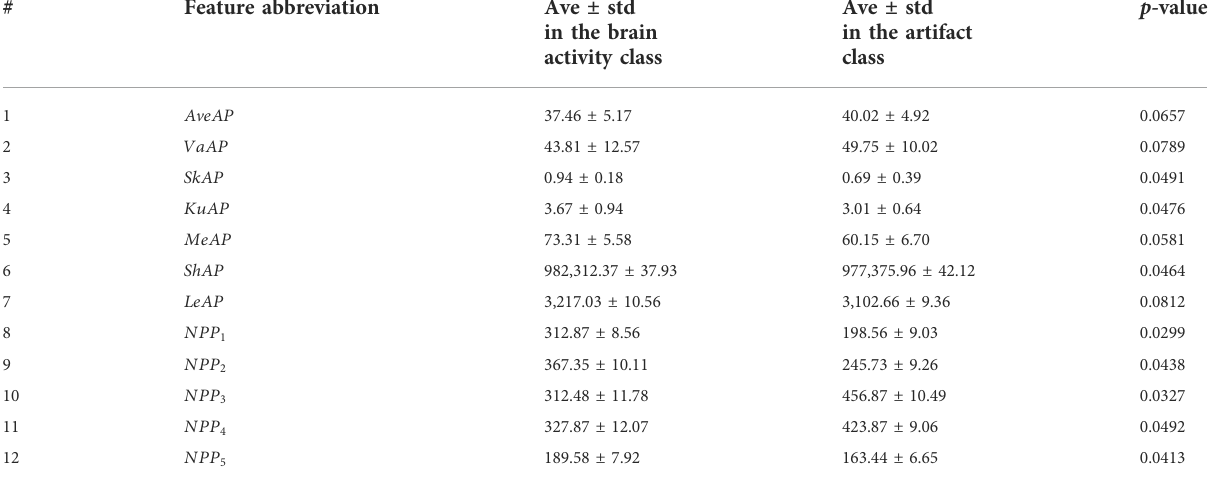
TABLE 5 Average and standard deviation values for the proposed features. T-test was performed for the proposed features, and p -values were reported.